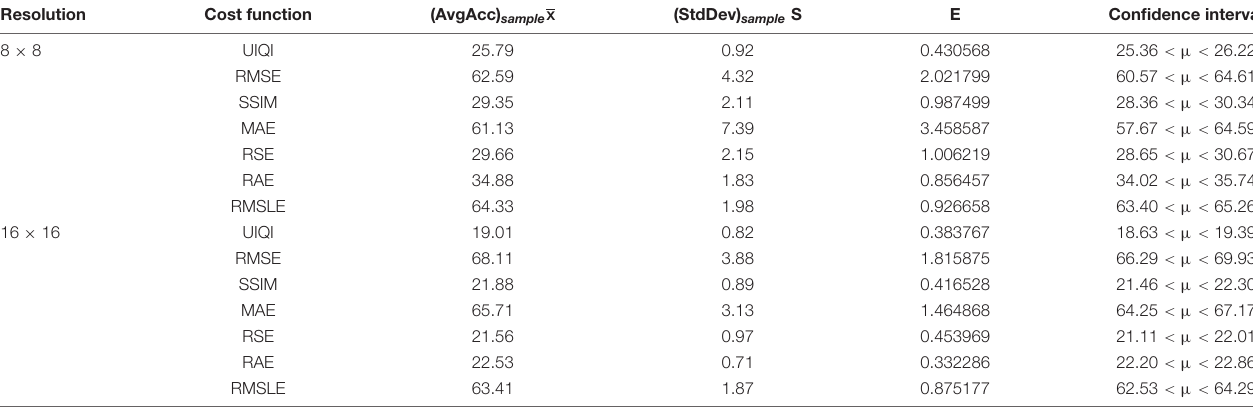
TABLE 5 | Multiple resolution t -test analysis of cost functions based on 95% confidence interval ( α = 0.05) and unknown population mean for sample size n = 20 with error margin E using t α / 2 = 2.093. Resolution